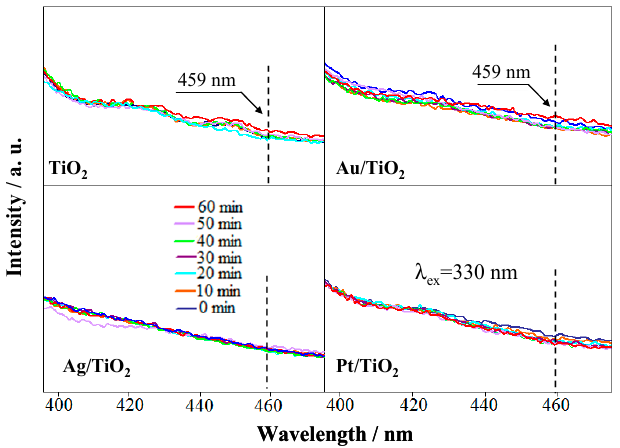
Figure 8. Coumarin formation survey, indicative of · OH radical formation, upon exposure to visible light ( λ > 420 nm) of catalysts dispersed in aqueous media.